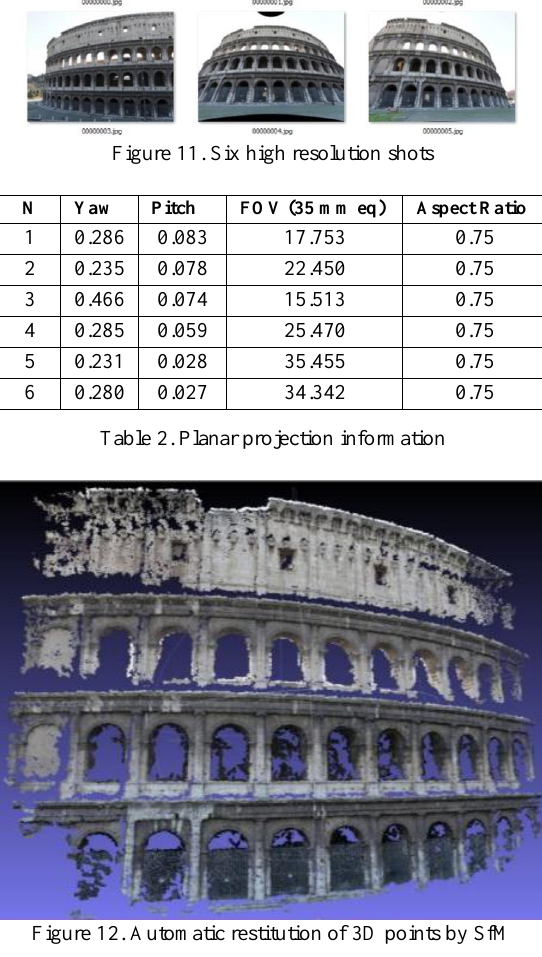
In the same way internal points are automatically extracted to cover the whole perimeter of the Coliseum.